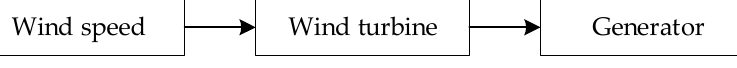
Figure 5. Basic operation model of wind generation.